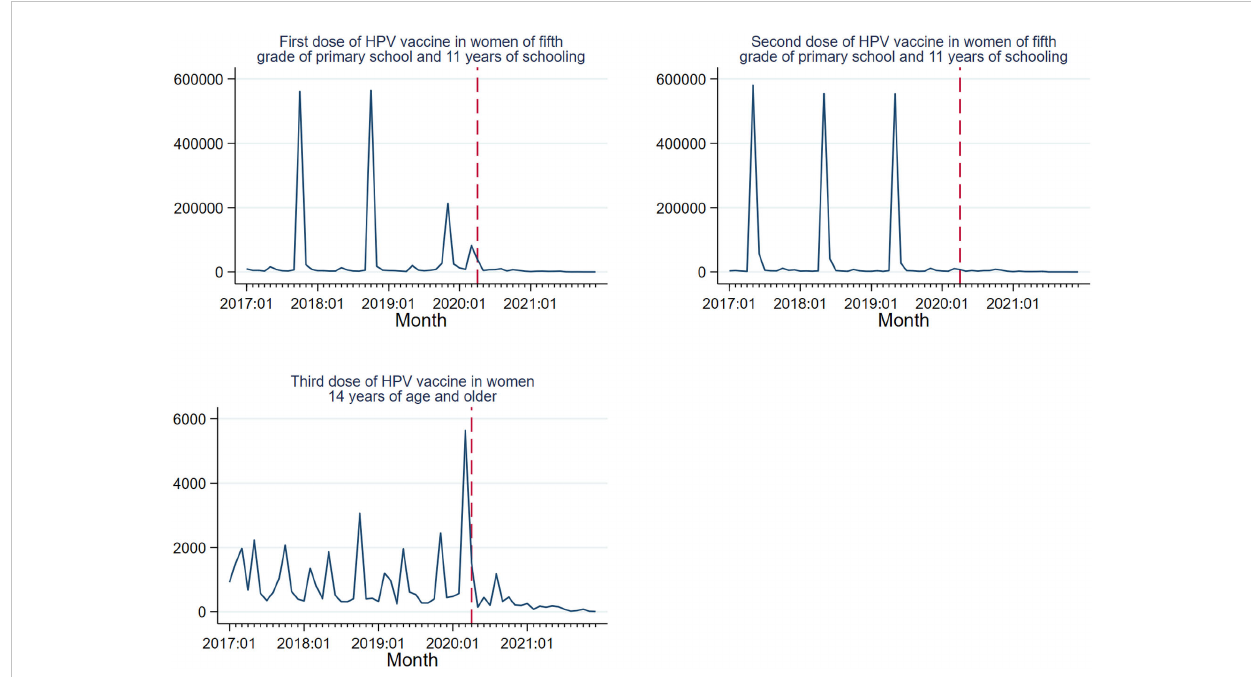
FIGURE 1 HPV vaccination trends 2017 – 2021. Mexico. Source: Outpatient provided services information system. 2017-2021.